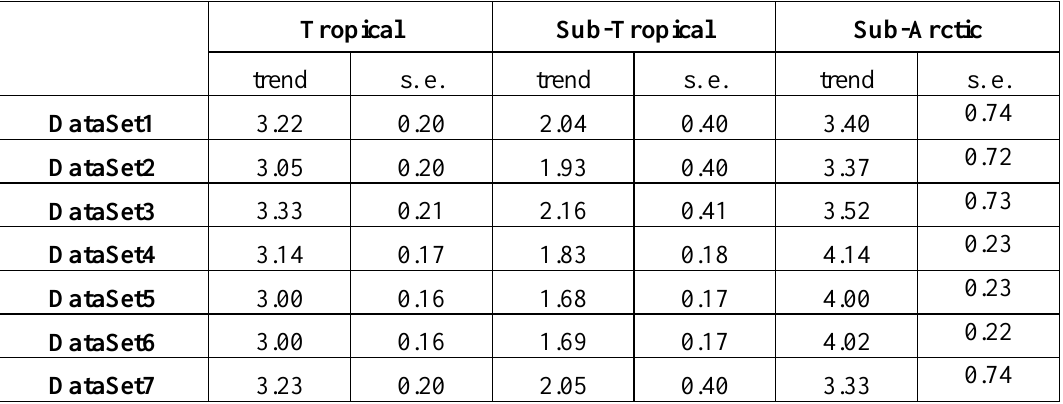
Table 4. Linear trends (mm/yr) and corresponding standard errors (mm/yr) obtained by OLS fit to the original SLA time series (after removing the seasonal signal).